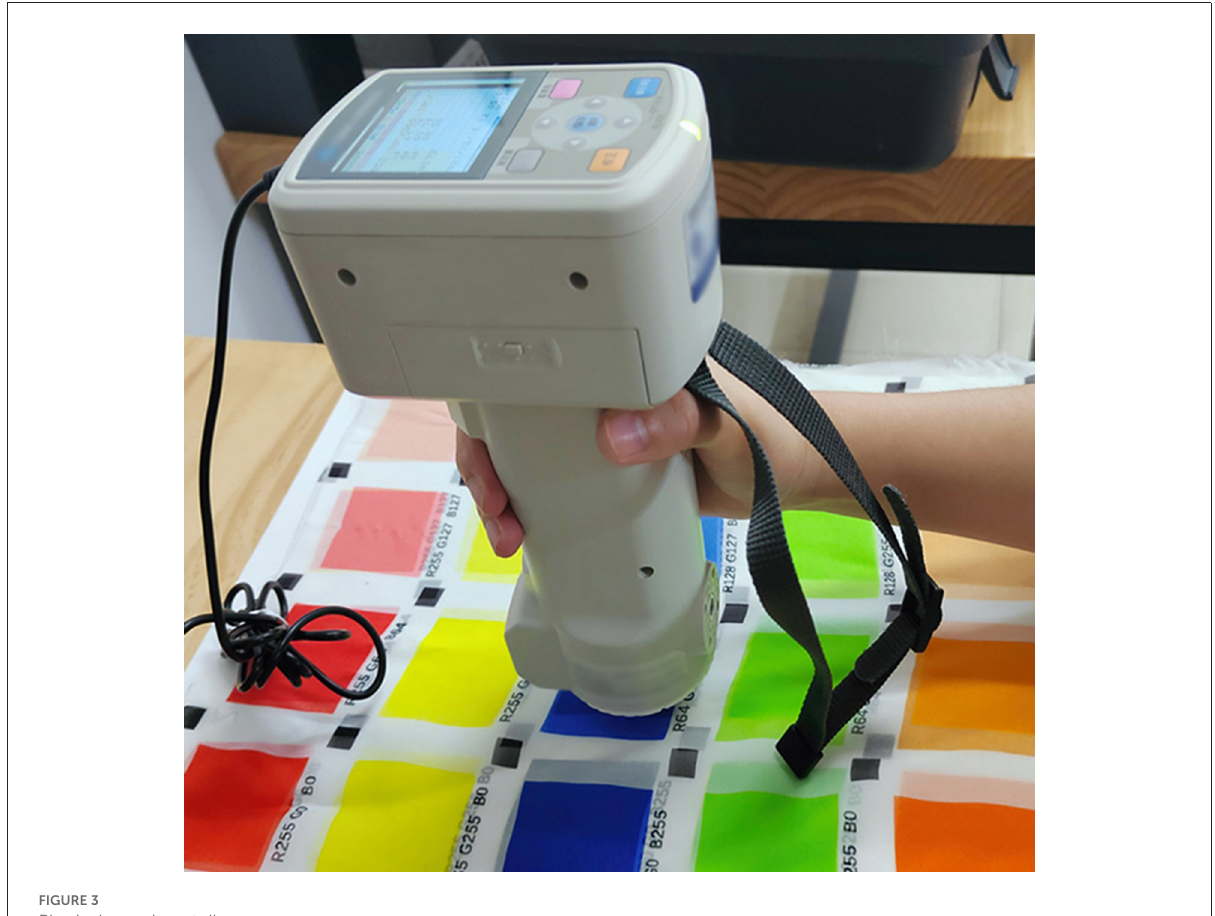
FIGURE3 Physical experiment